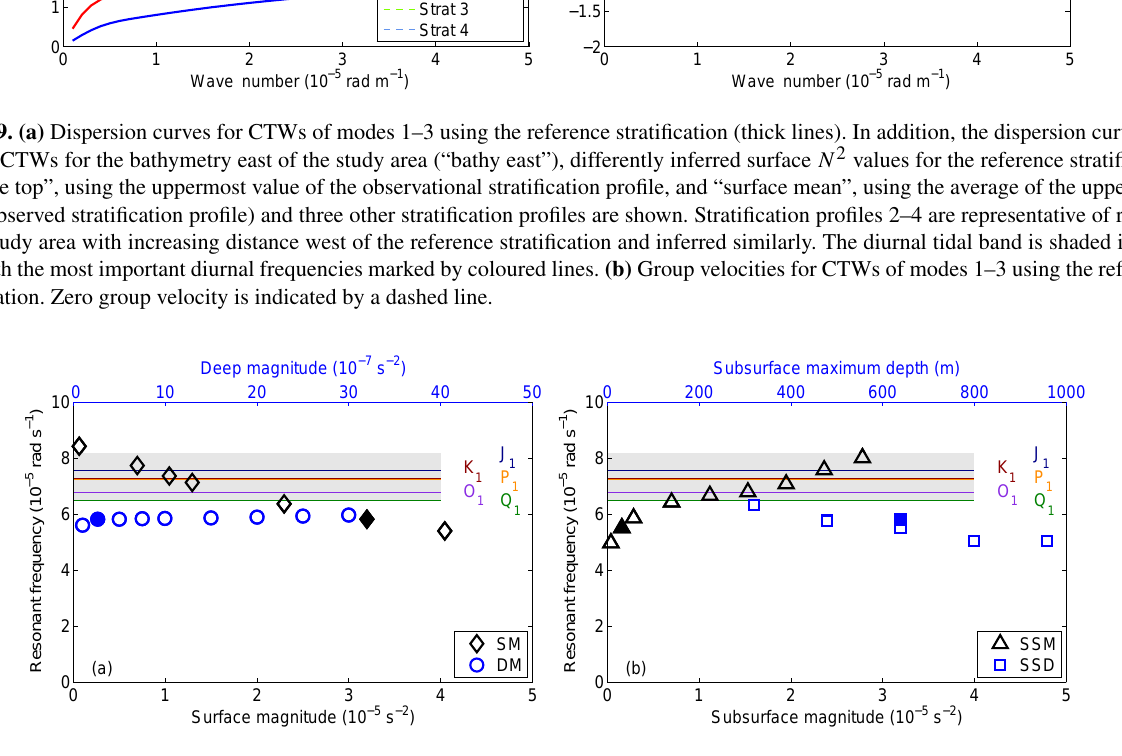
Figure 10. Sensitivity test for changing stratification. (a) The surface magnitude (SM) and deep magnitude (DM) are varied. (b) The sub- surface magnitude (SSM) and its depth (SSD) are varied. Results from the reference stratification profile are indicated by filled markers. For the case of SSD, the shape of SSM in the profile is simplified (open marker below filled marker) and then varied in depth. The diurnal tidal band is shaded in light grey with the most important diurnal frequencies marked by coloured